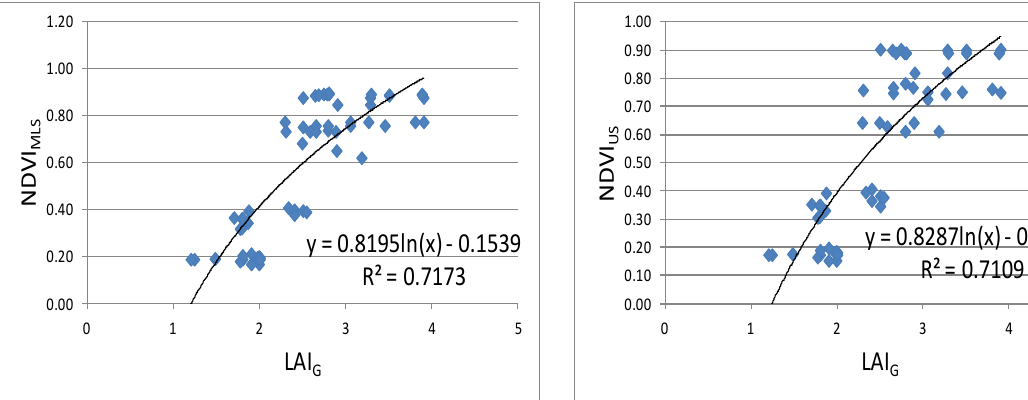
Figure 9: Relationship of LAI G and NDVI MLS for wheat crop Figure 10: Relationship of LAI G and NDVI US for wheat crop